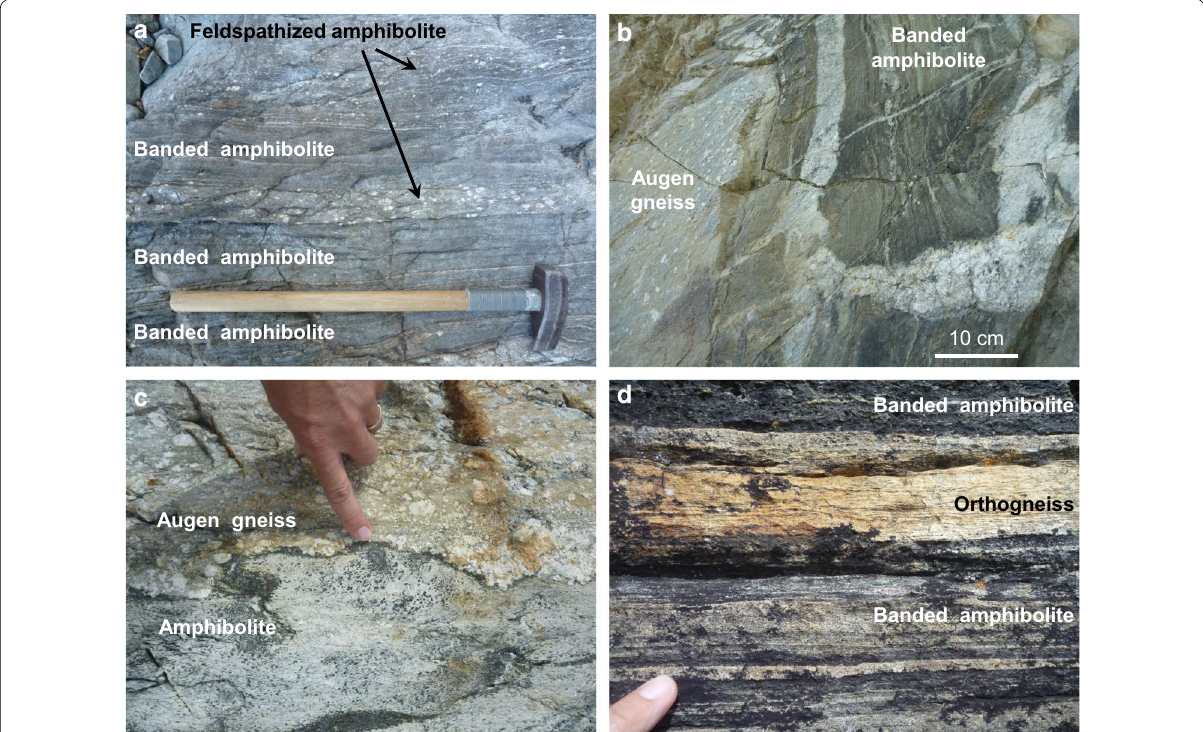
Fig. 3 Relationships between banded amphibolites and orthogneisses. a Feldspathized layers in a banded amphibolite (Strona-Ceneri Zone, south of Molinetto, Italy, Swiss coordinates: 2 ʹ 698 ʹ 120/1 ʹ 100 ʹ 035; for localization see also Fig. 1c). b Agmatite composed of schollen of banded amphibolite in a matrix of augen gneiss (Aar Massif, forest road from Betten Dorf to Martisberg, Valais, Switzerland, Swiss coordinates: 2 ʹ 649 ʹ 608/1 ʹ 136 ʹ 702). c Reaction rim between amphibolite and augen gneiss (Aar Massif, Chazulecher, Valais, Switzerland, Swiss coordinates: 2 ʹ 647 ʹ 461/1 ʹ 139 ʹ 792). d Banded amphibolite with intercalated layer of orthogneiss (Gotthard Nappe, Northwest of Lago die Dentro, Val Piora, Ticino, Switzerland, Swiss coordinates: 2 ʹ 699 ʹ 394/1 ʹ 156 ʹ